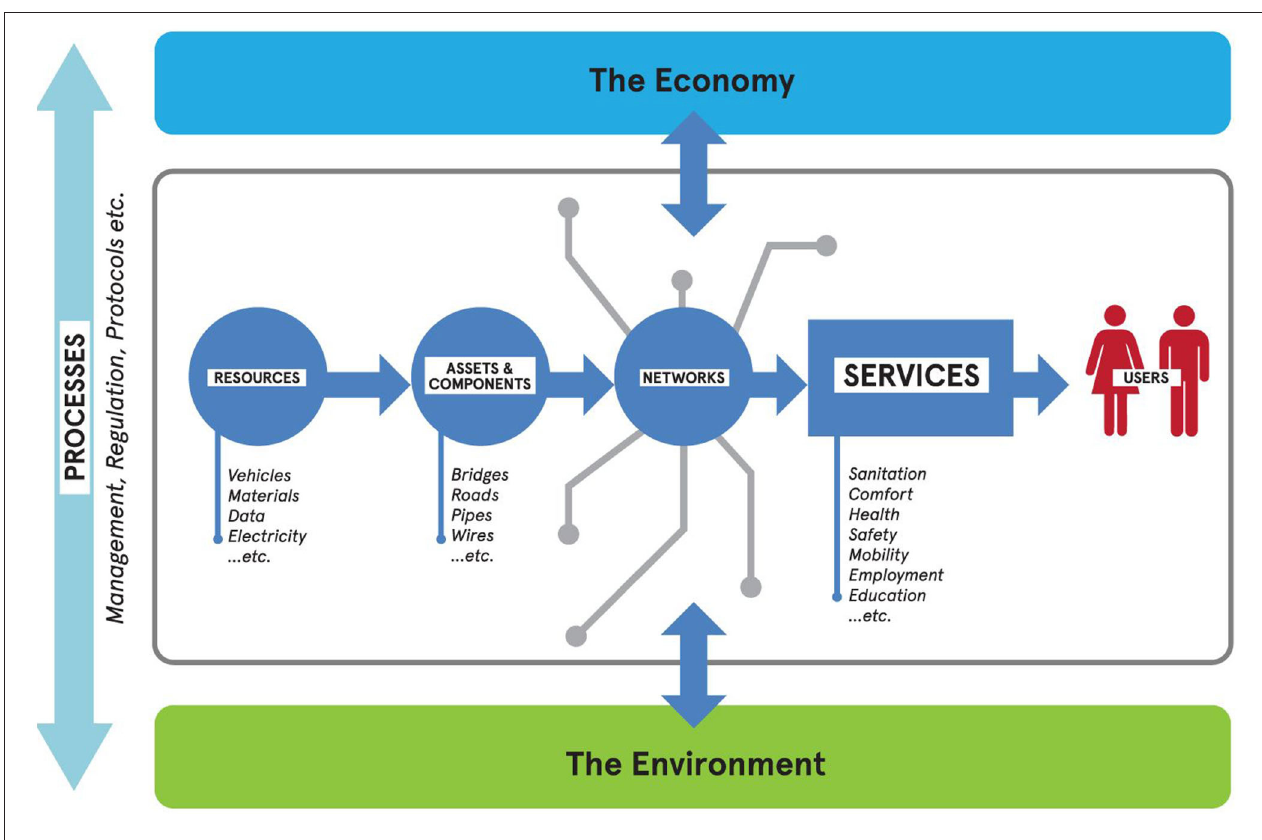
FIGURE 2 | A systems view of